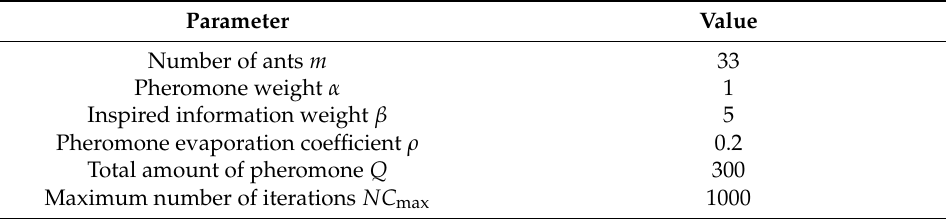
Table 1. Parameter settings of the ACO